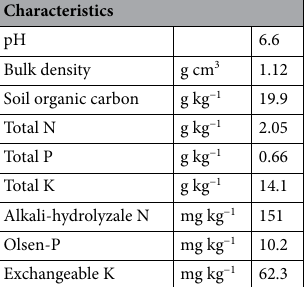
Table 4. Soil basal characteristics in 0–15 cm soil layer in